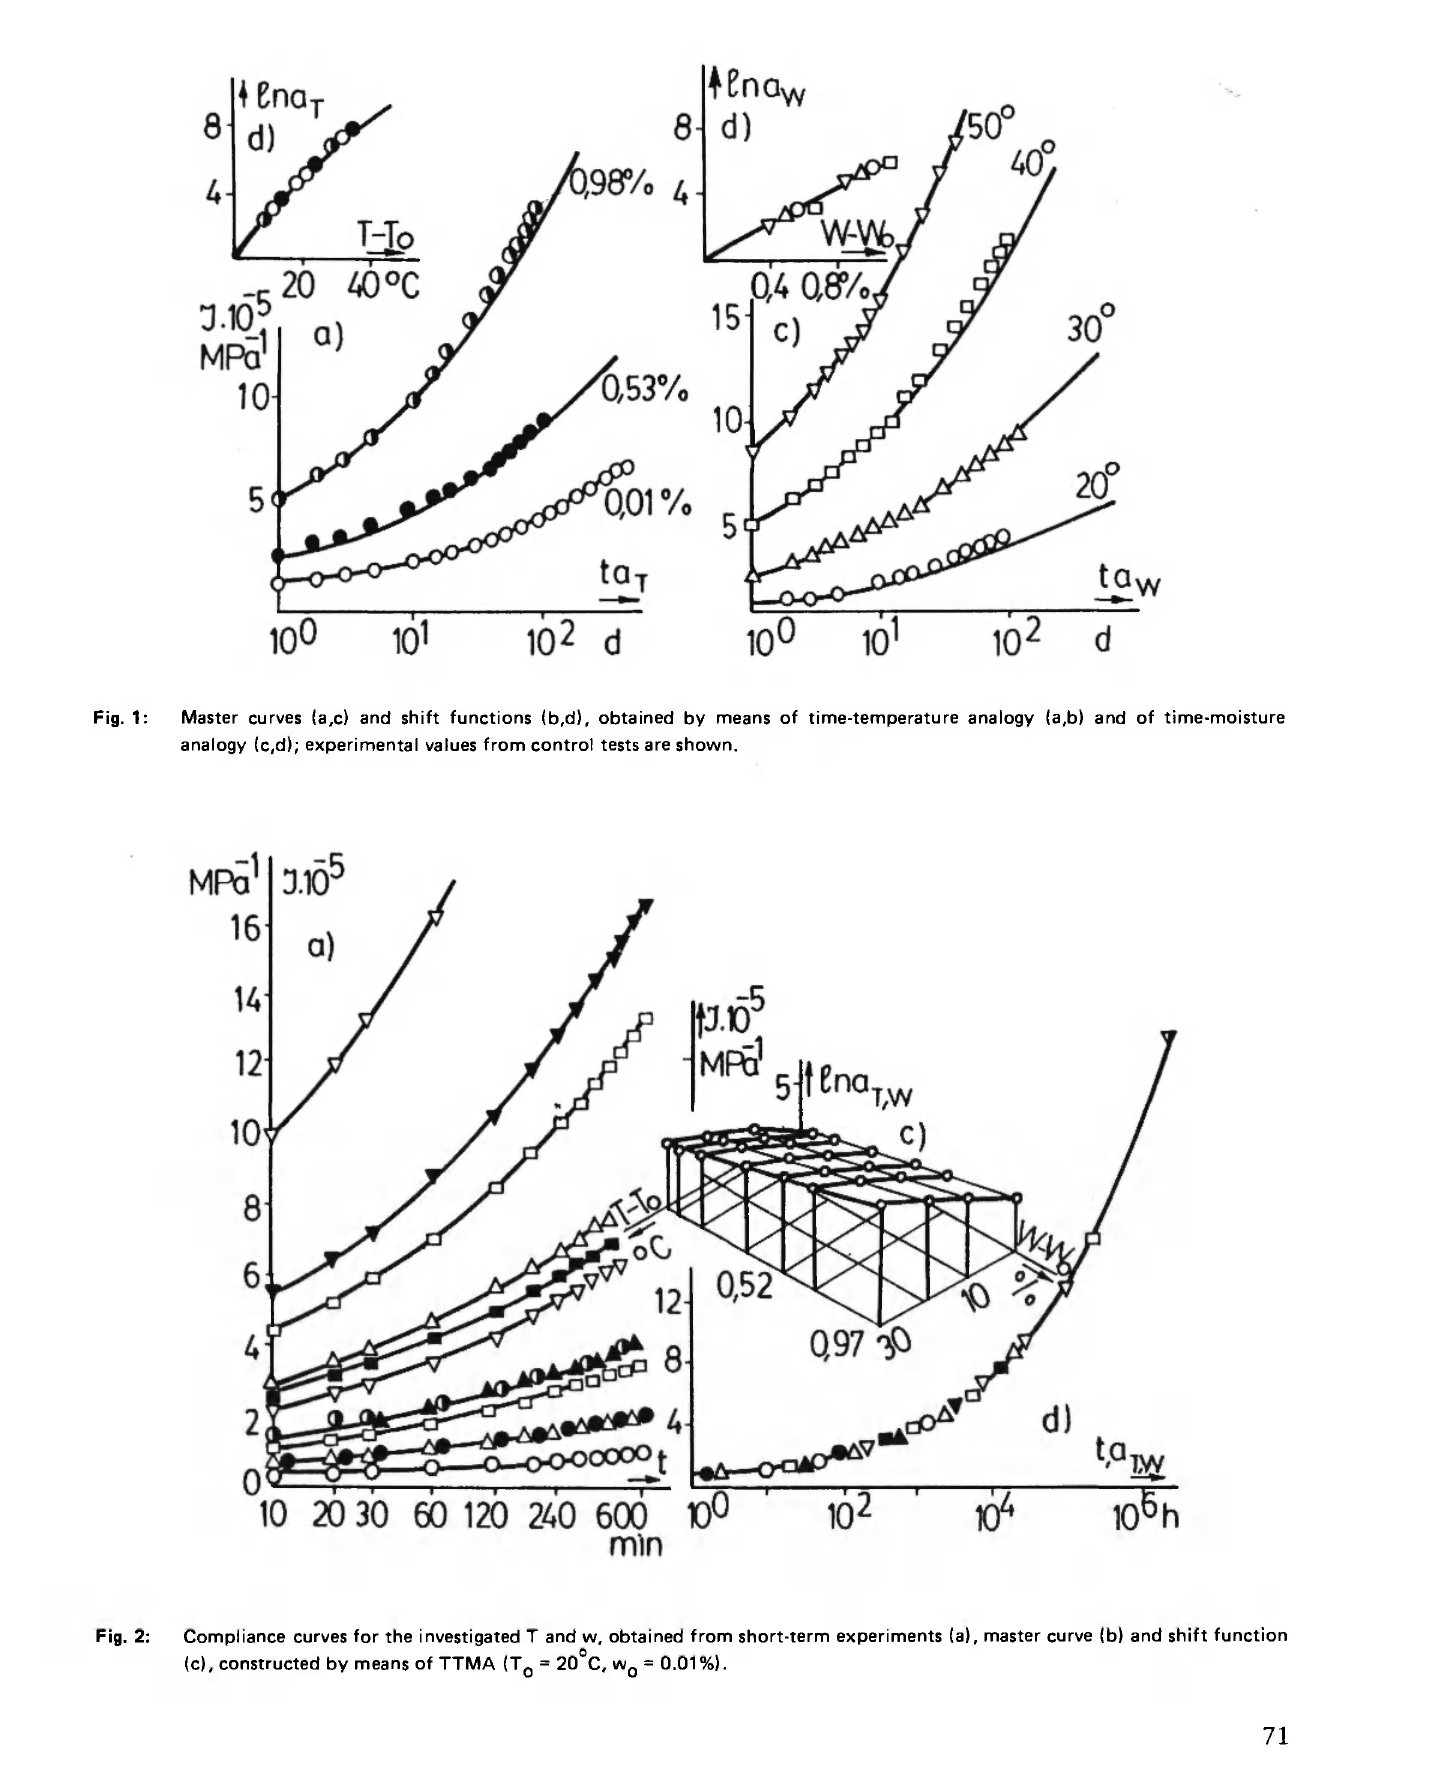
Fig. 2: Compliance curves for the investigated Τ and w, obtained from short-term experiments (a), master curve (b) and shift function (c), constructed by means of TTMA (T Q = 20°C, vn Q = 0.01%).